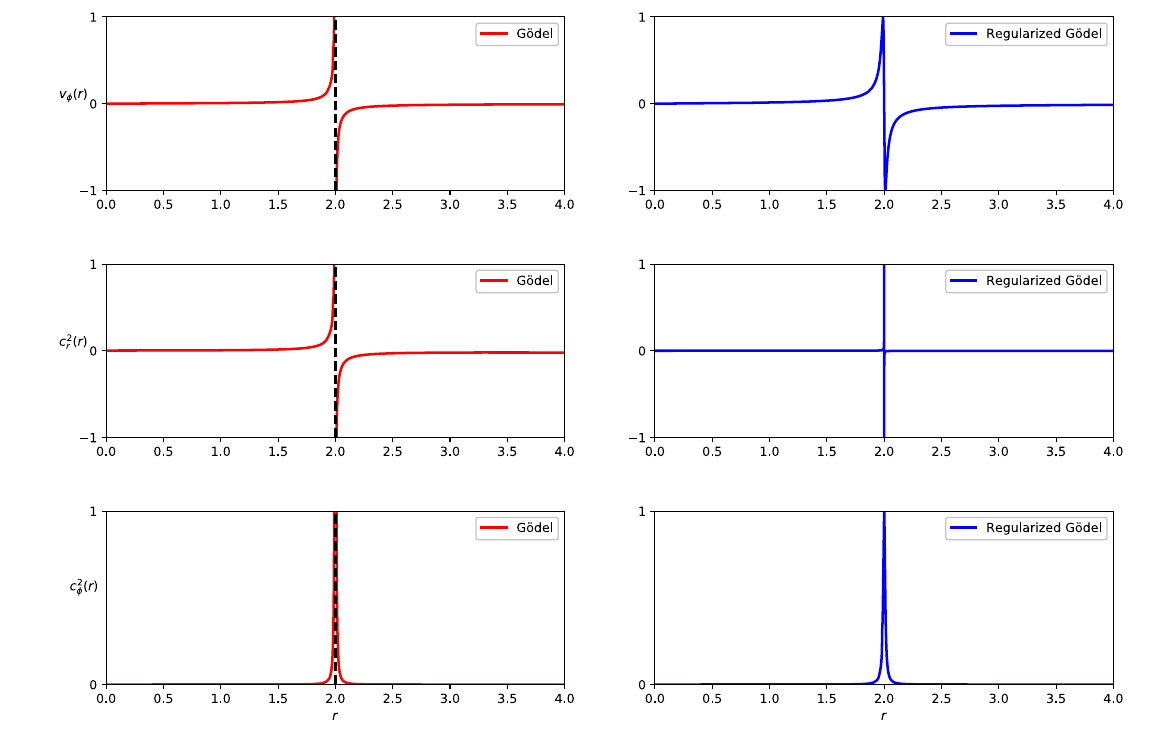
Fig. 1 The left panel represents the anisotropic speeds of sound and the azimuthal velocity of the fluid required to perform an analogue simulation of Gödel’s geometry for ω = 1. All of them display a ver- tical asymptote at r = r C . The right panel displays the corresponding anisotropic speeds of sound and the azimuthal velocity of the fluid for